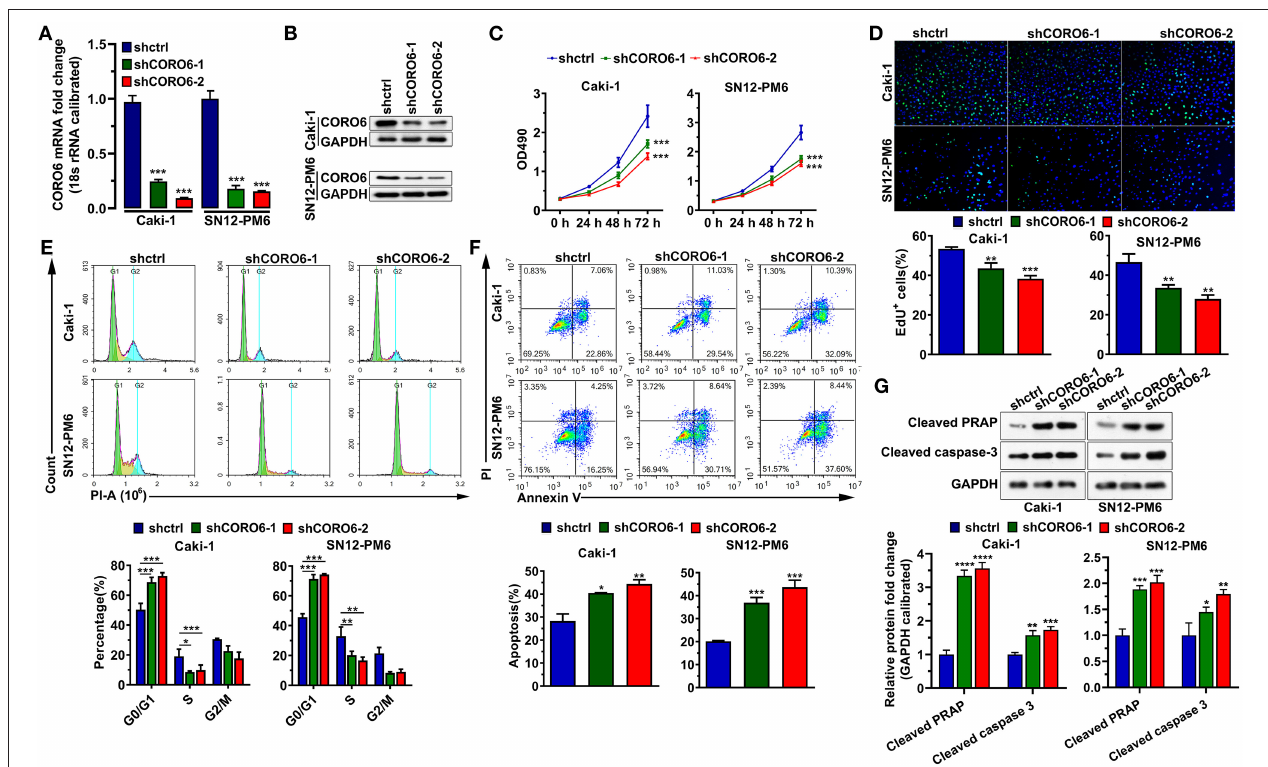
FIGURE 5 | CORO6 enhanced ccRCC cell growth. (A,B) Knockdown efficiency of shRNAs against CORO6 by qPCR (A) and Western blotting (B) . (C) The MTT assay revealed that CORO6 reduction suppressed Caki-1 and SN12-PM6 cell growth. (D) EdU staining showed that CORO6 reduction decreased Caki-1 and SN12-PM6 cell proliferation. Top: representative images of EdU staining. Bottom: statistical analyses. (E) PI-stained flow cytometry analysis showed that CORO6 depletion caused cell cycle arrest at G0/G1 in Caki-1 and SN12-PM6 cells. (F) Annexin V-/PI-stained flow cytometry analysis indicated that CORO6 depletion increased Caki-1 and SN12-PM6 cell apoptosis. (G) Western blotting analyses revealed that CORO6 knockdown increased expression levels of cleaved PRAP and cleaved caspase-3. Top, representative image of western blotting analyses. Bottom, a statistical analyses. GAPDH was a loading control. * P < 0.05, ** P < 0.01, *** P < 0.001, and **** P <